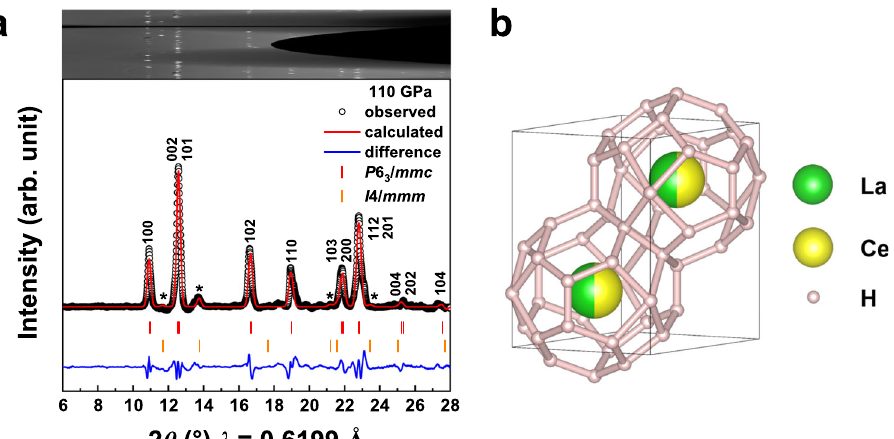
Fig. 2 | Structuraldatafor (La,Ce)H 9 synthesized fromLa-Cealloyand NH 3 BH 3 . a Synchrotron X-ray diffraction pattern of the La-Ce alloy hydrides obtained fol- lowing laser heating and the Rietveld re fi nement of the P 6 3 / mmc -(La,Ce)H 9 struc- ture at 110GPa. The cake view of raw XRD pattern is shown in the upper inset. The high-intensity points caused by single-crystal-like diffraction (e.g., the points at